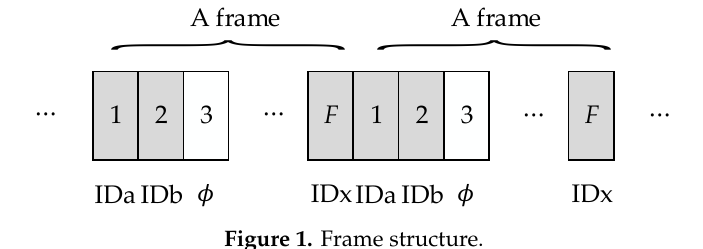
Figure 1. Frame structure.